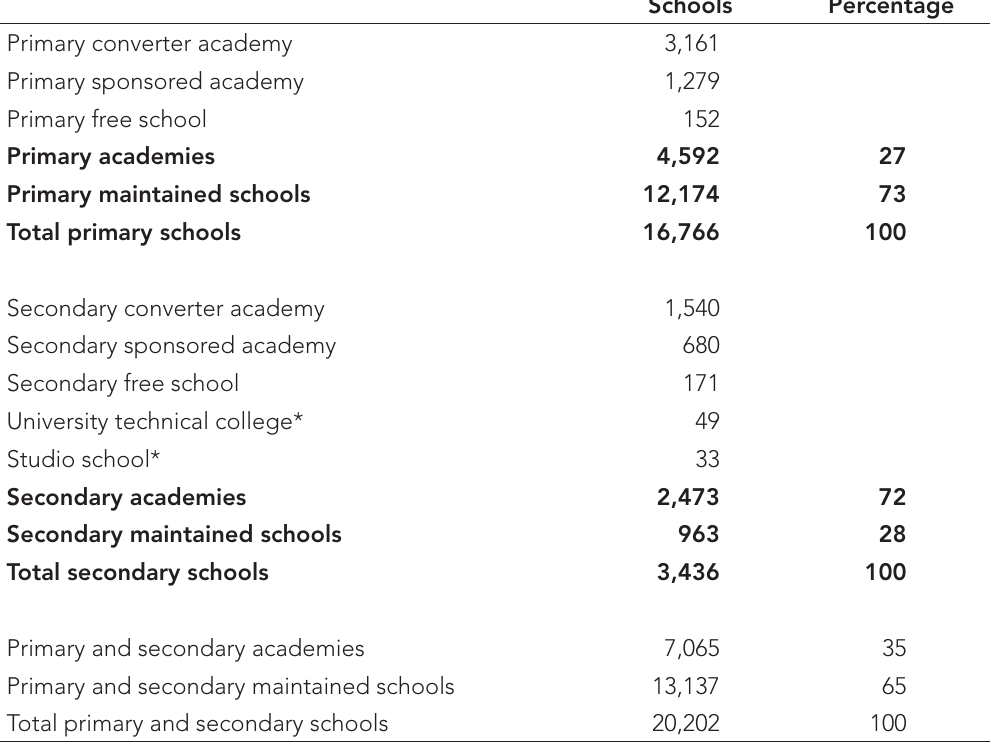
Table 1: State-funded primary and secondary schools in England (January